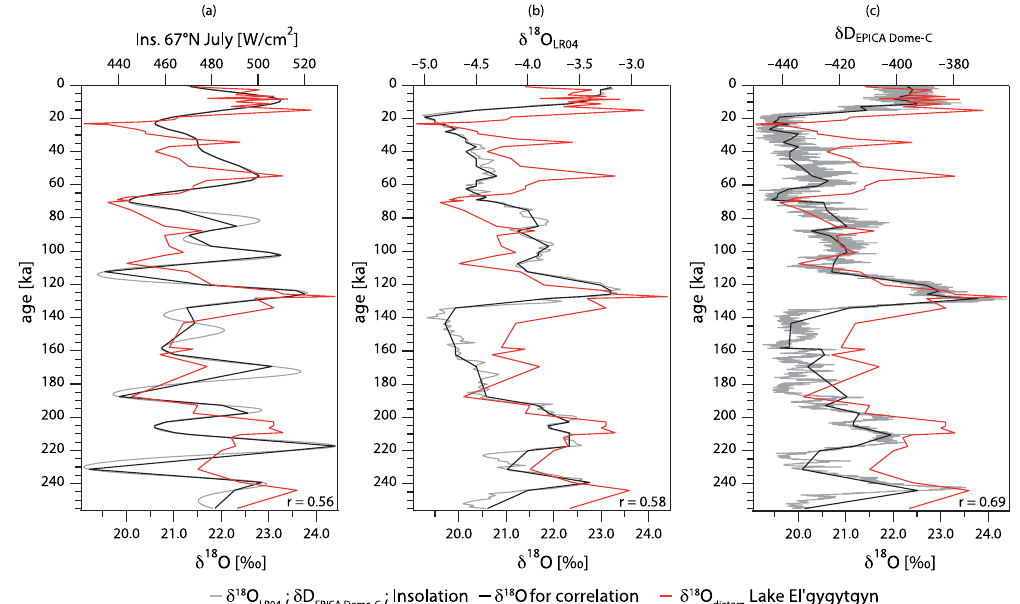
Fig. 9. Correlation between the δ 18 O diatom record and (a) mean monthly insolation (July) (b) the marine LR04 stack and (c) the δ D EPICA Dome-C